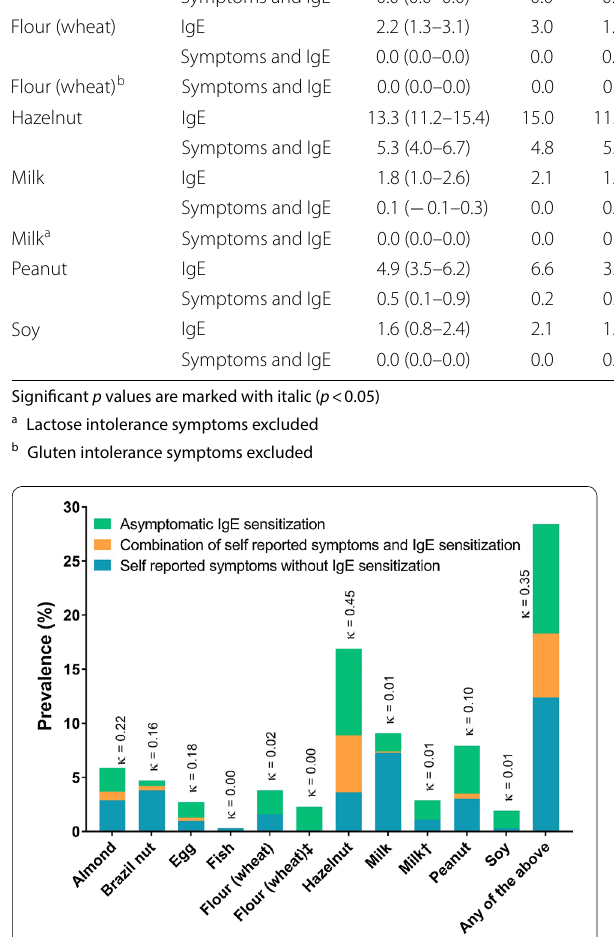
Fig. 2 The prevalence of subjects with self-reported symptoms, IgE-sensitisation, and combination of self-reported symptoms with IgE sensitisation for the different common foods. Correspondence between symptoms and IgE-sensitisation using kappa-coefficients (κ < 0.2 for slight or poor agreement; κ 0.21–0.4 for fair agreement; κ 0.41–0.6 for moderate agreement; κ 0.61–0.8 for substantial agreement and κ 0.81–1 for almost perfect agreement). Dagger: Lactose intolerance symptoms excluded. Double dagger: